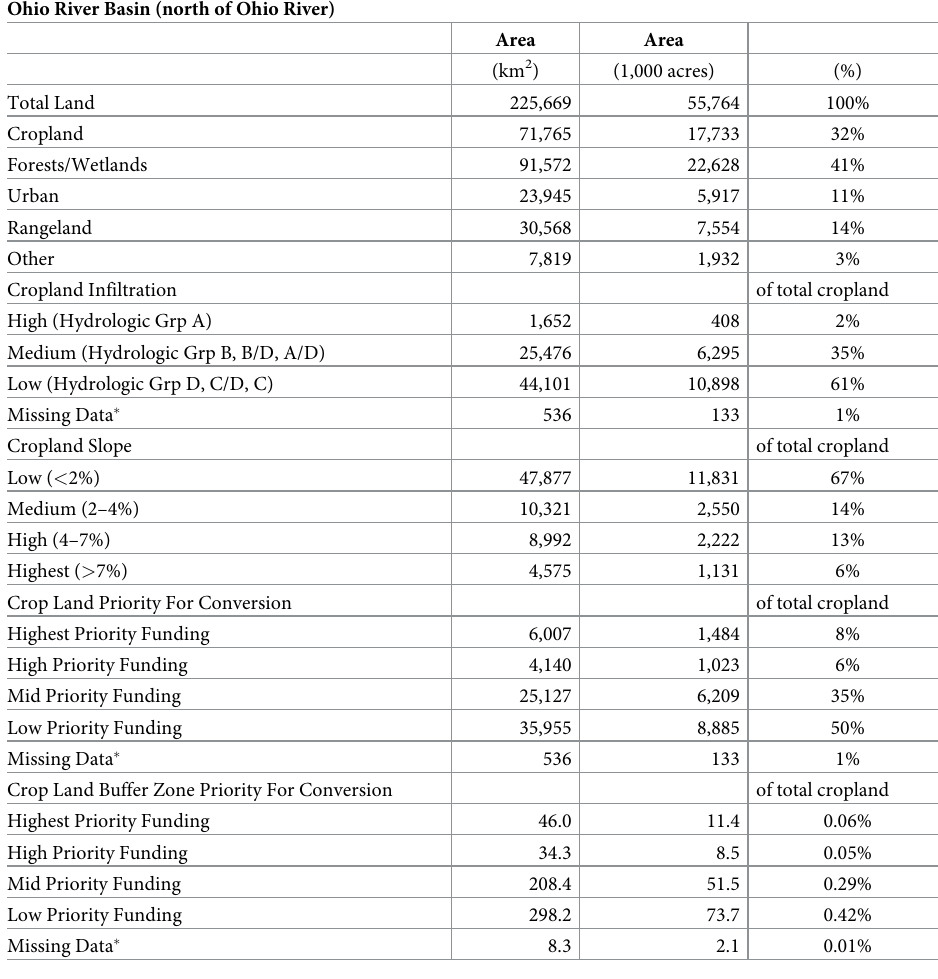
Table 3. Availability of high priority cropland fields for reforestation in the northern Ohio River